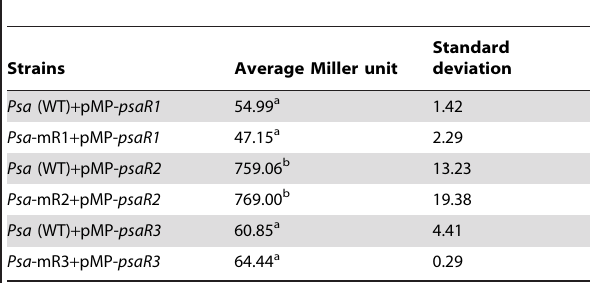
Table 3. Expression and auto-regulation of psaR1, psaR2 and psaR3. Table 4. Expression and regulation of